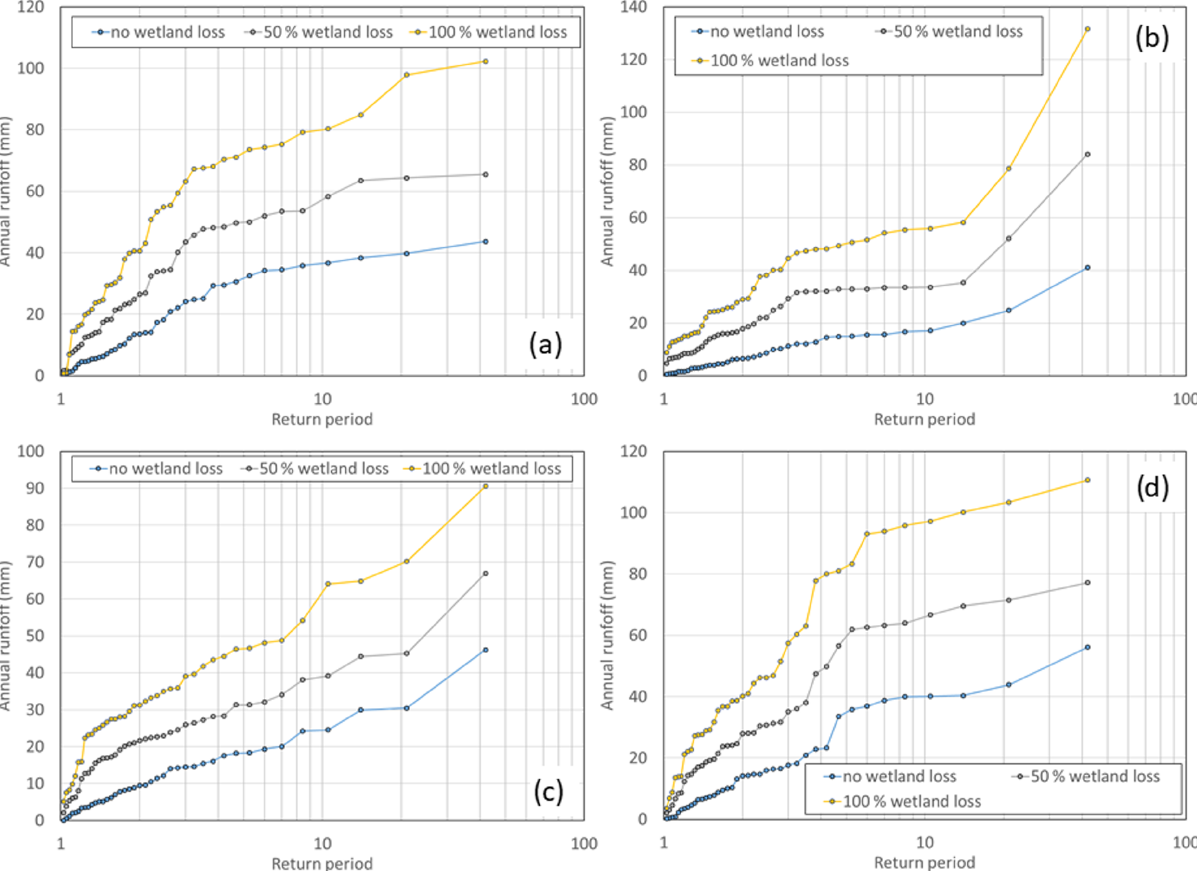
Figure 9. Flood frequency curves for the four climate locations at (a) Yorkton, (b) North Battleford, (c) Estevan, and (d) Brandon for no wetland loss, 50% wetland loss by area, and complete wetland loss, using the small-to-large wetland drainage scenario.